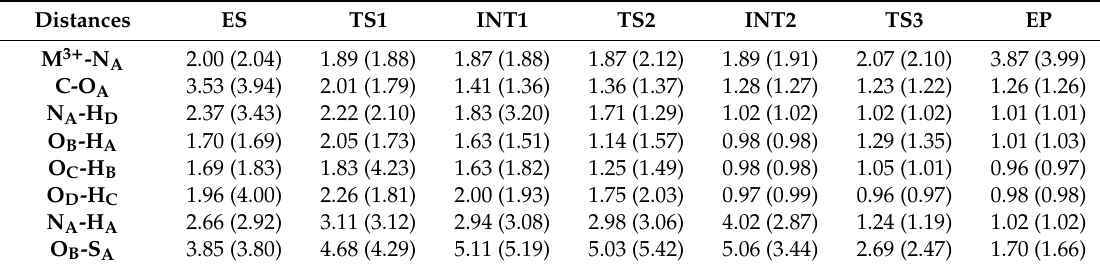
Table 3. Main geometrical parameters (having Scheme 4 as reference) obtained for the stationary points from the PES of Co 3 + -NHase and Fe 3 + -NHase (in parenthesis) [132]. All values are in Å. Distances ES TS1 INT1